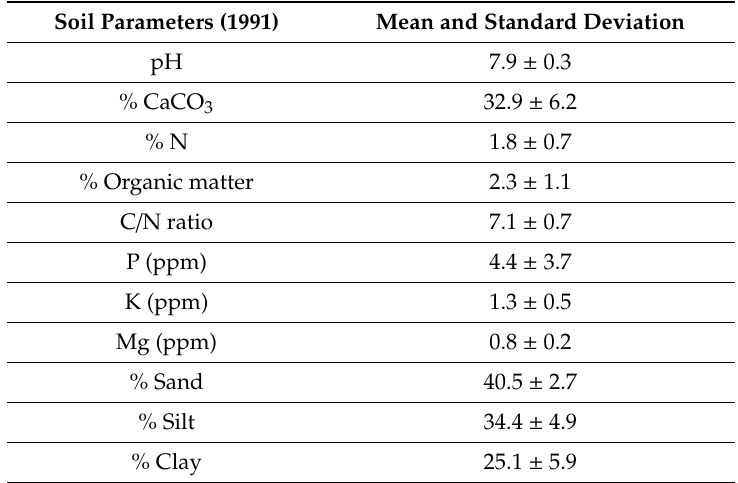
Table 1. Mean and standard deviation values of the studied soil parameters in